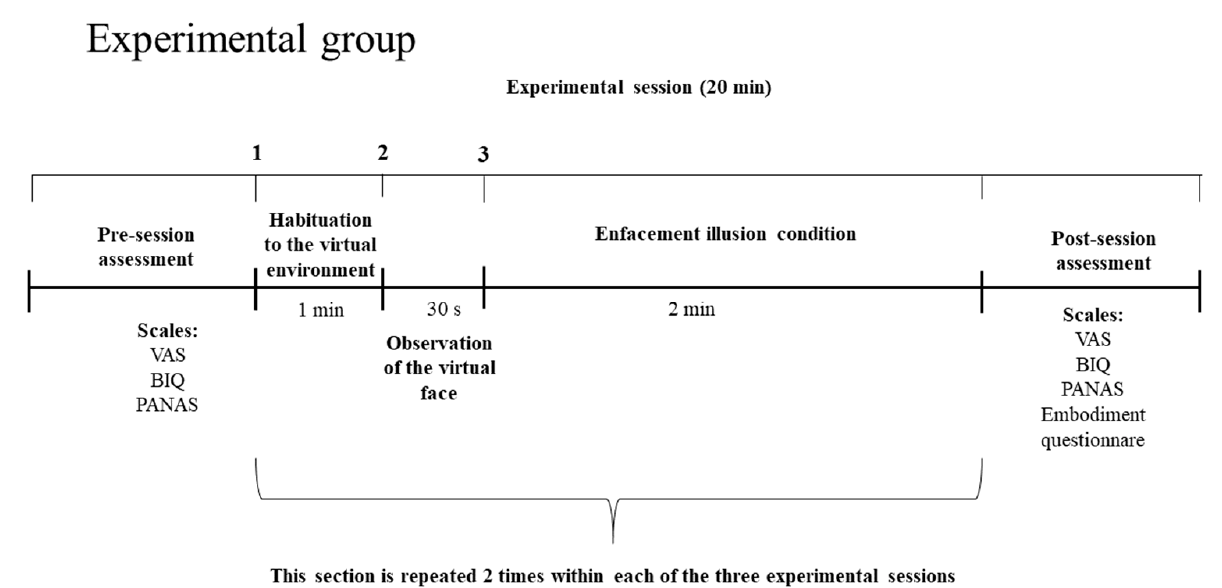
Figure 3. Timeline of each experimental session for the experimental group.